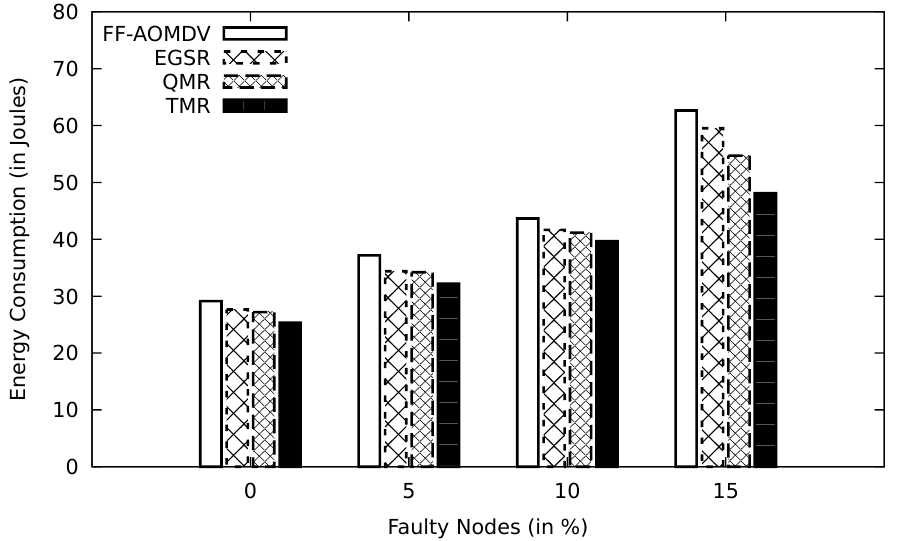
Figure 13. Comparison of FF-AOMDV, EGSR, QMR, and proposed protocol TMR for energy con- sumption with faulty